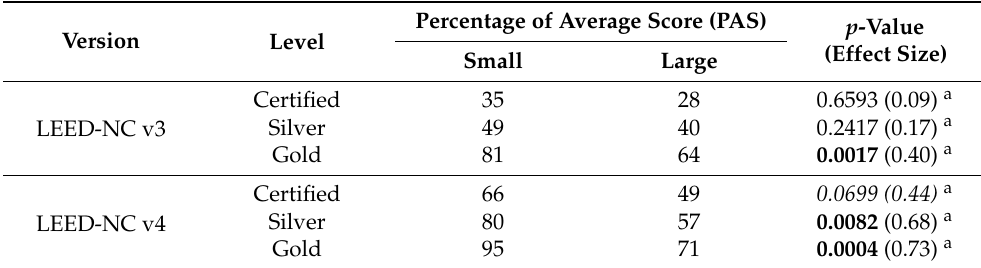
Table 8. LEED-NC v3/v4 office-type projects: operational energy